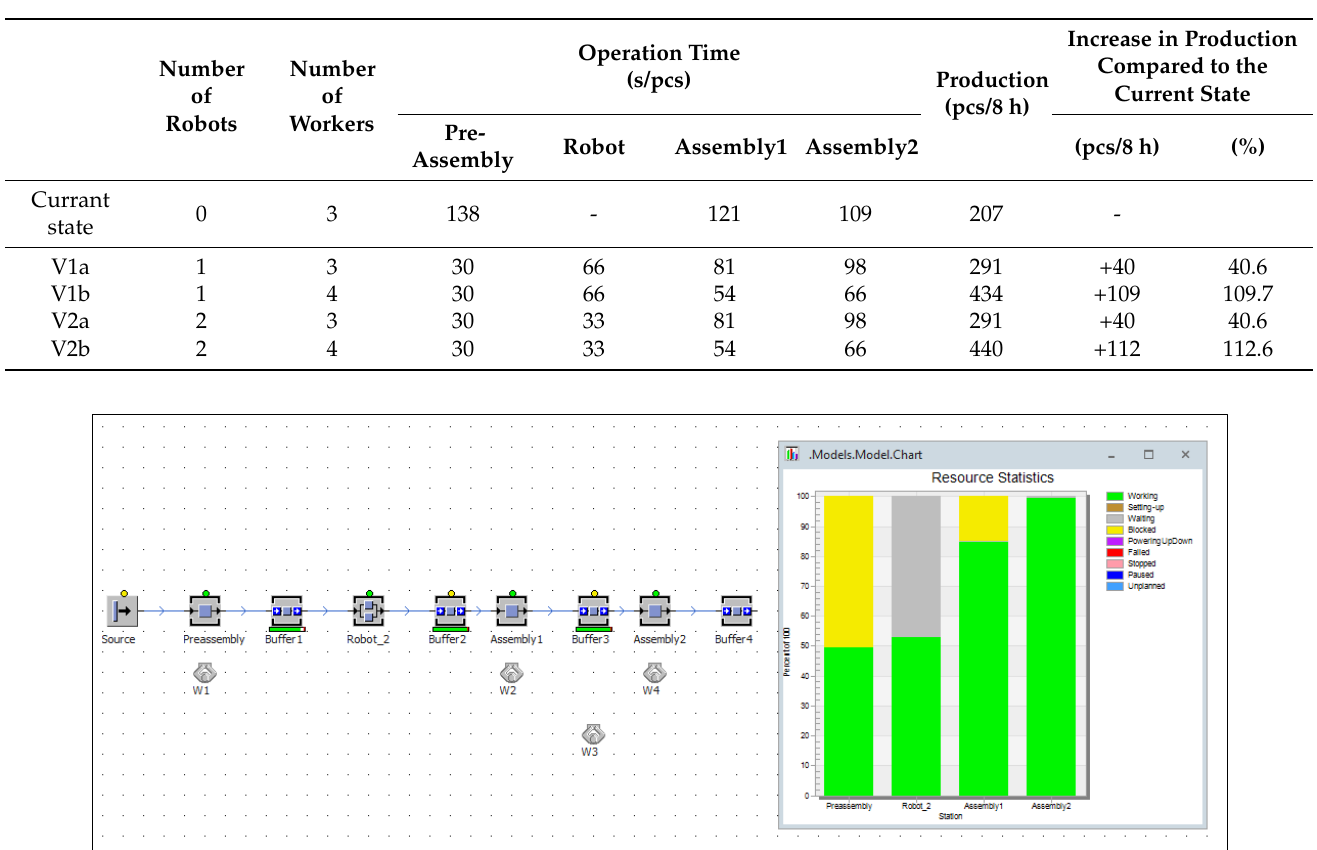
Table 4. Comparison of the production parameters of the proposed investment variants with the current state. Figure 6. Variant 2a (two robots, three people).